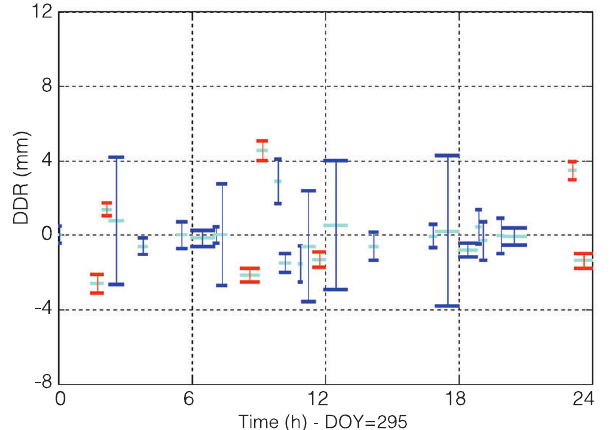
Fig. 4. Double differences residuals versus time for DOY: 295 of the year 1999 for the GPS stations Padua and Medicina (Italy). Lines: cyan-mean DDR; blue- standard deviation; red-anomalous